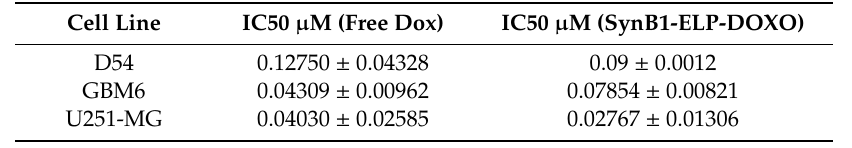
Table 1. IC50 values of human glioblastoma cell lines.